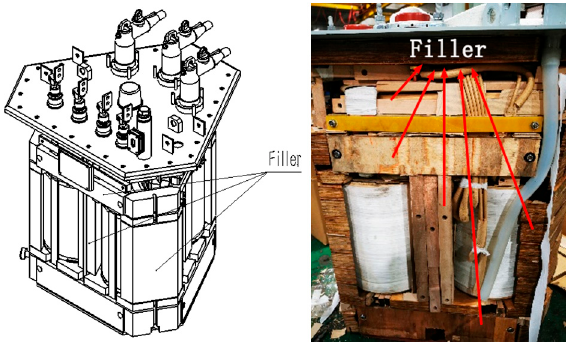
Figure 8. F iller design and actual filling effect. Figure 8. Filler design and actual filling